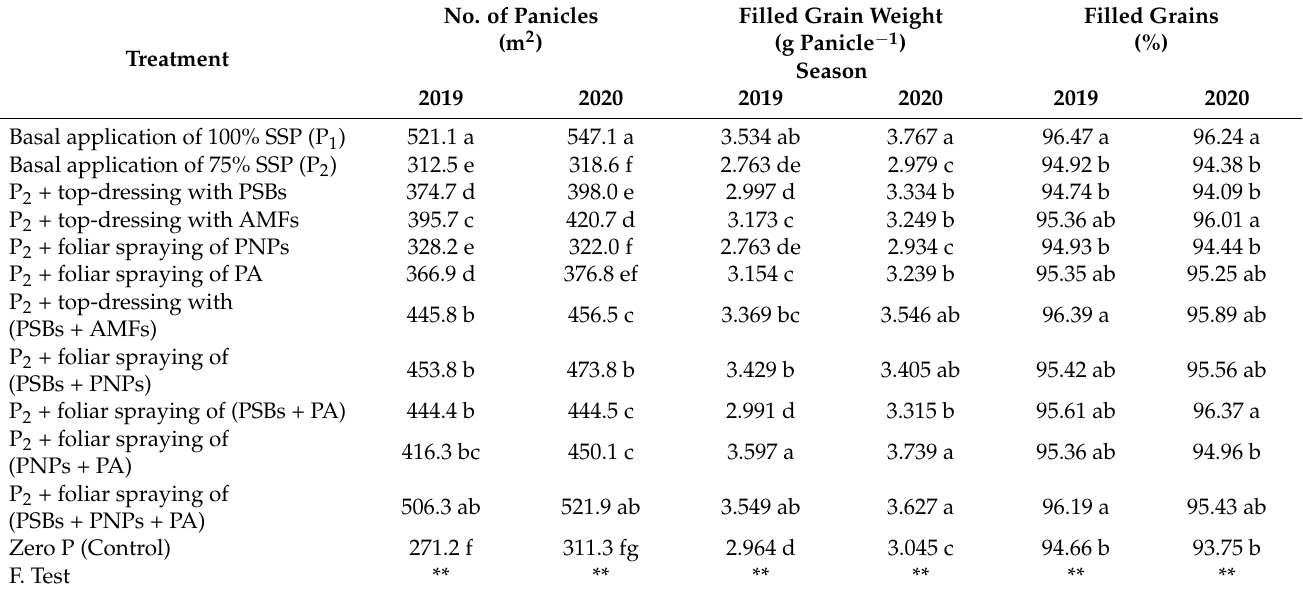
Table 3. Number of panicles, filled grain weight per panicle and filled grain percentage of Sakha 106 rice cultivar were affected by arbuscular mycorrhizal fungi, phosphate-solubilizing bacteria and selected chemical phosphorus fertilizers in the 2019 and 2020